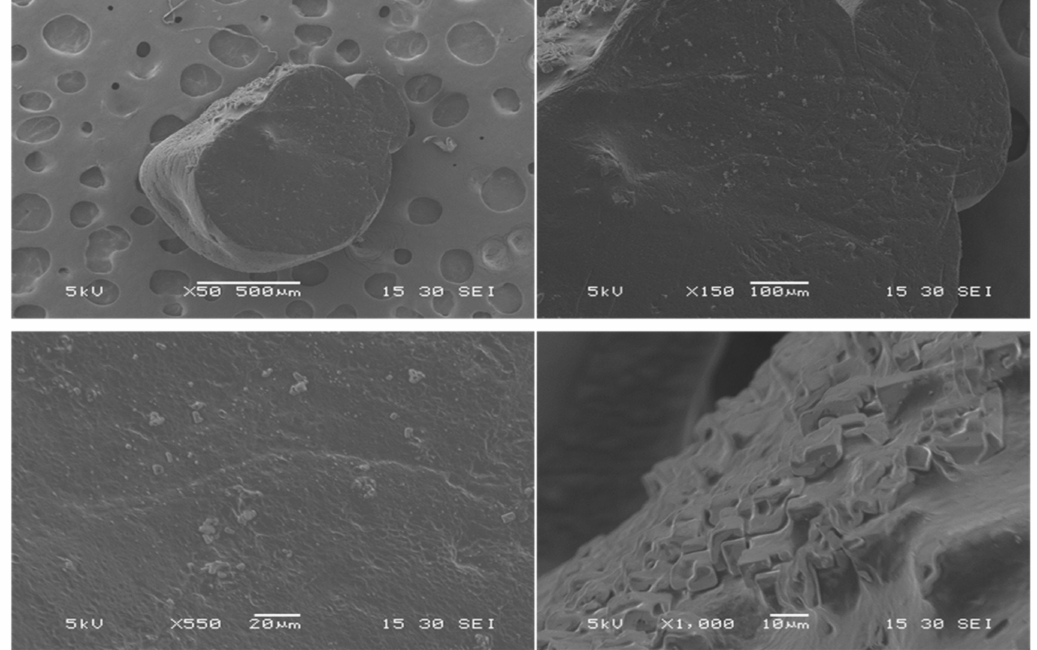
Figure 3. SEM analysis of CUR-MCT-KC_2 bead (higher MCT concentration used) showing smoother surface features. SEM analysis was performed at 5 kV over a magnification of × 50 to ×